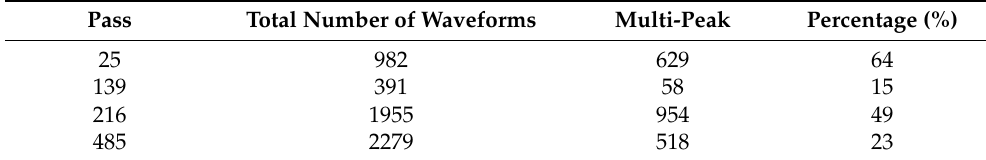
Figure 14. Example of waveforms from pass 139 over the Persian Gulf at 0 to 10 km from the coast. Table 5. Waveform statistical information.